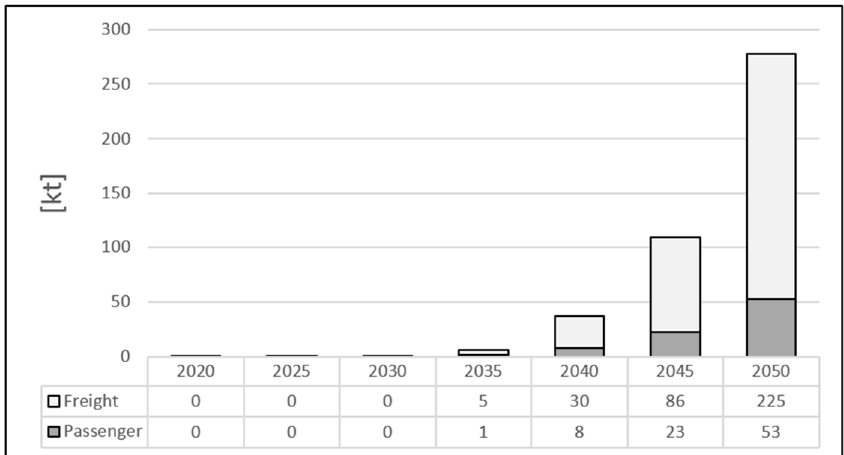
Figure 14. Hydrogen demand in passenger transport (cars and buses) and in freight transport (HDV’s) [NEU scenario] [kt]. Source: own calculations based on TR 3 E model results. (HDV’s) [NEU scenario] [kt]. Source: own calculations based on TR 3 E model